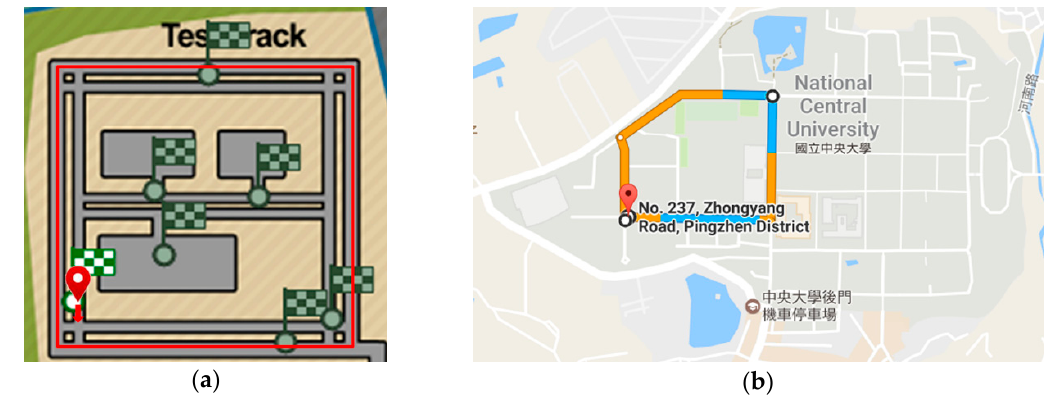
Figure 8. ( a ) The route in the simulated environment. ( b ) The real-traffic route.